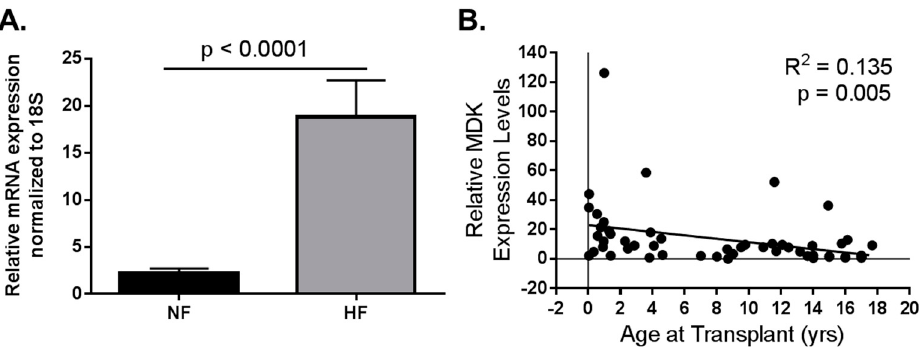
Figure 2. Data adapted from Tatman et al. (2017) [57]. Pediatric MDK mRNA expression in LV from non-failing (NF) and failing hearts (HF). ( A ) MDK mRNA is upregulated in left ventricle (LV) from pediatric HF patients when compared to age-matched NF controls. NF n = 21; HF n = 36; p < 0.0001;